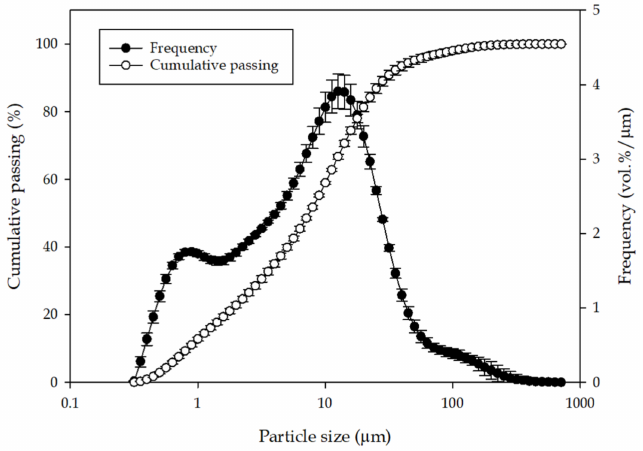
Figure 2. Particle size distribution of representative feed sample obtained via laser diffraction